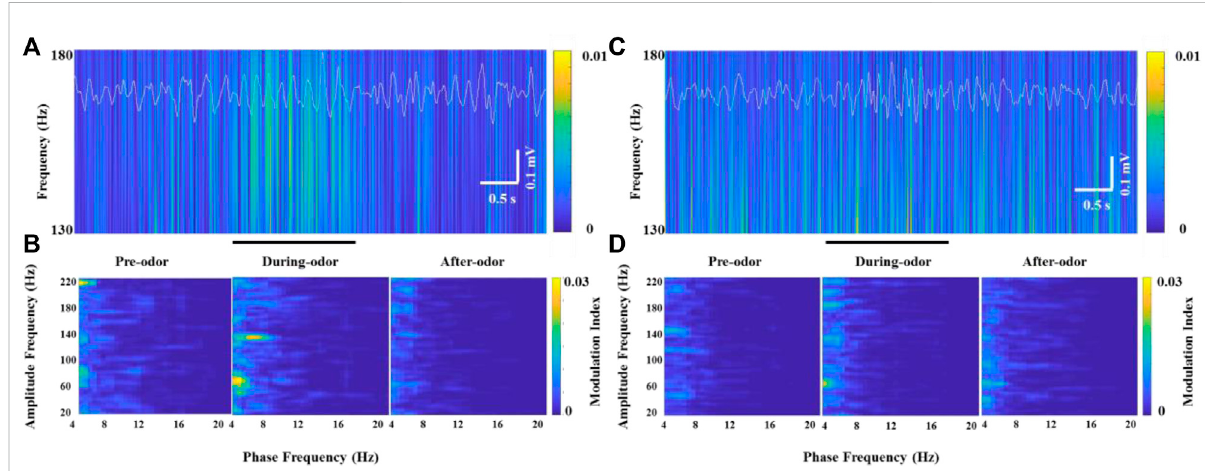
FIGURE 6 Exampleofspeci fi ccouplingbetween θ andhigh-frequencyoscillations(130 – 180 Hz)inanawakerat (A,B) andananesthetizedrat (C,D) during odor stimulation. (A) Wavelet spectrograms and superimposed θ signals (4 – 12 Hz, white traces) from the recorded OB neurons in an awake rat pre- odor (left), during odor (middle), and after odor (right). (B) Comodulation maps obtained from the OB neurons of a freely moving rat pre-odor (left), duringodor(middle),andafterodor(right). (C) Waveletspectrogramsandsuperimposed θ signals(4 – 12 Hz,whitetraces)fromtherecordedOB neurons in an anesthetized rat pre-odor (left), during odor (middle), and after odor (right). (D) Comodulation maps obtained from the OB neurons of an anesthetized rat pre-odor (left), during odor (middle), and after odor